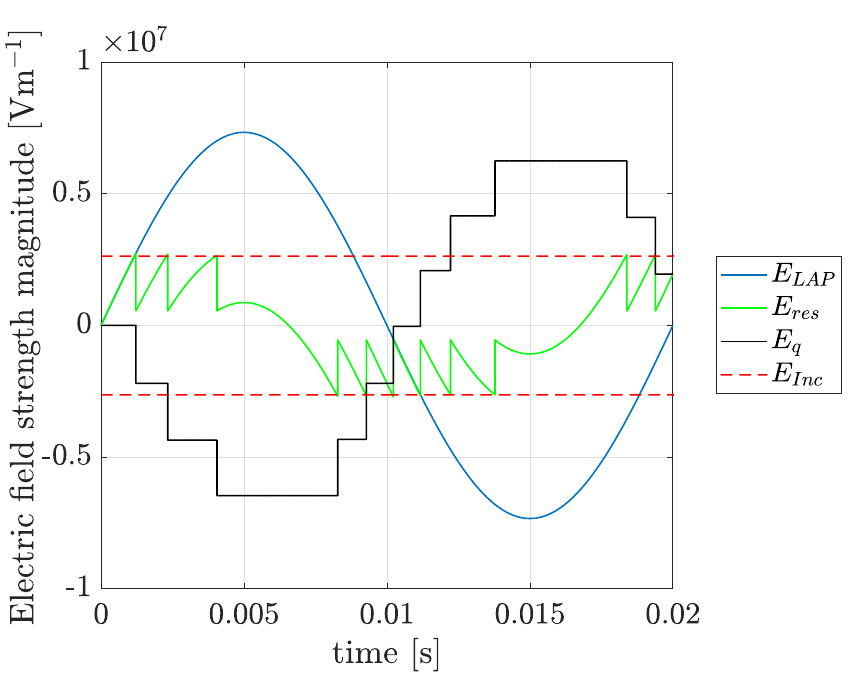
Figure 3. Superposition of the electric field strength magnitudes during the first cycle of the ageing Phase A. E LAP in Figure 4.